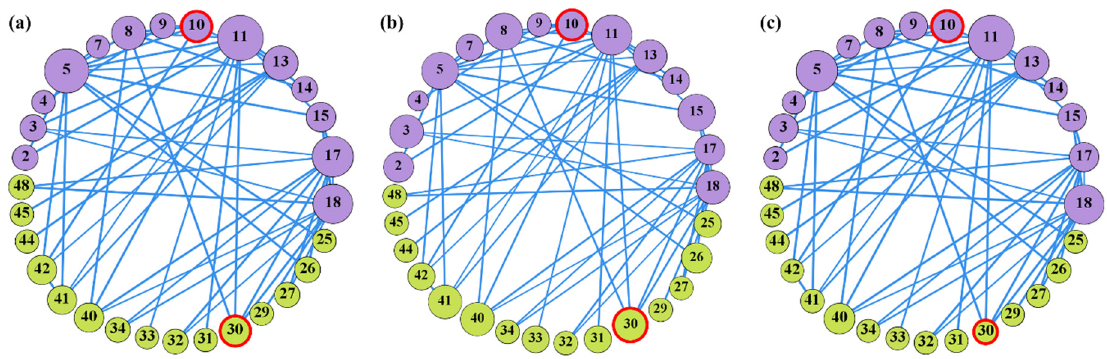
Figure 8. Analysis result of the groundwater-centered CB network without governance-related indicators for coastal cities. Node strength ( a ), closeness centrality ( b ), and betweenness centrality ( c